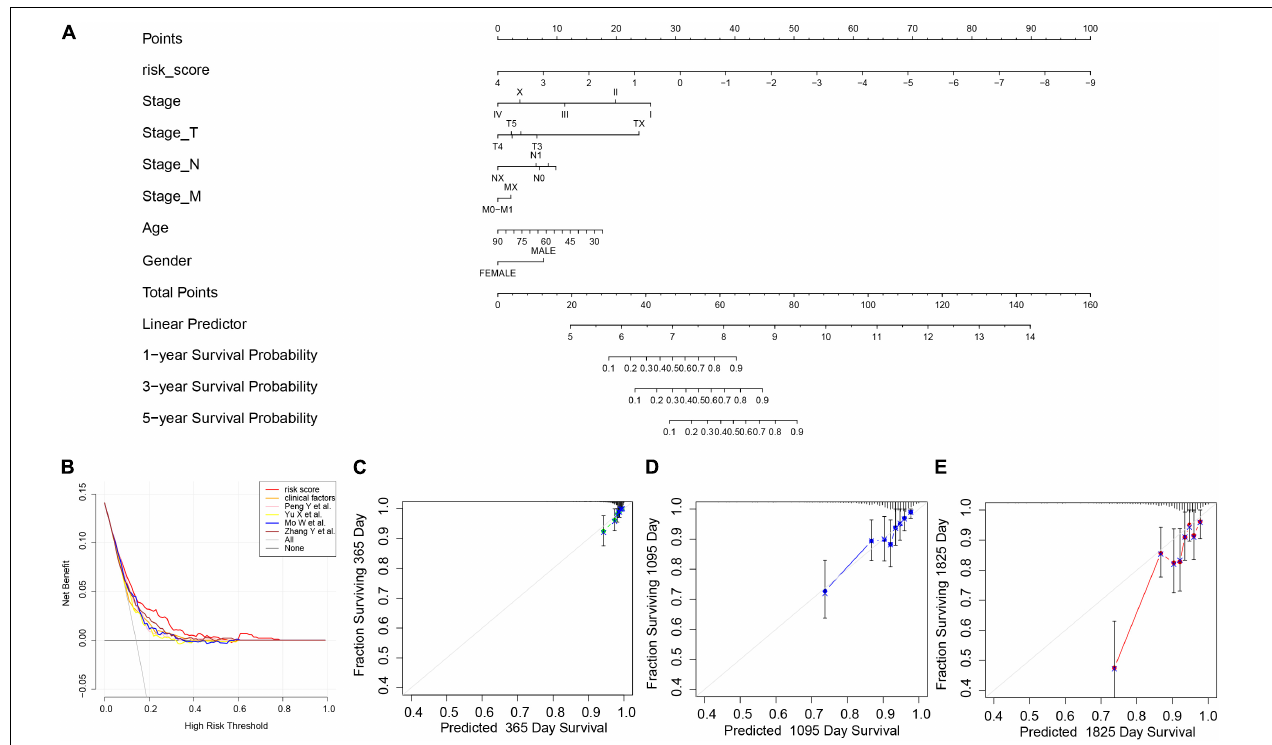
FIGURE 7 | The nomogram of GVRM and its clinical benefit. (A) Nomogram for predicting 1-, 3-, and 5-year survival probability of BRCA patients in the training group. The total score of clinical characteristics, as well as risk score for each patient, is located on the “Total points” axis, which corresponds to the survival probabilities plotted on the three axes below. (B) Decision curve for the risk model, clinical factors, and other existing prognostic models. (C–E) Calibration curves for nomogram in 1-, 3-, and 5-year, respectively.